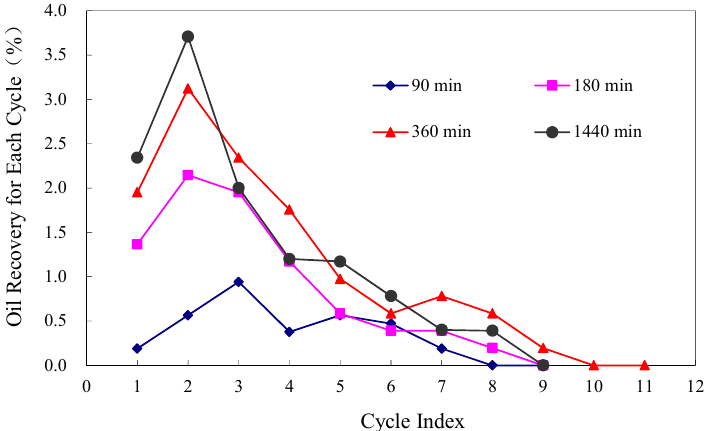
Figure 5. Oil recovery for each cycle of